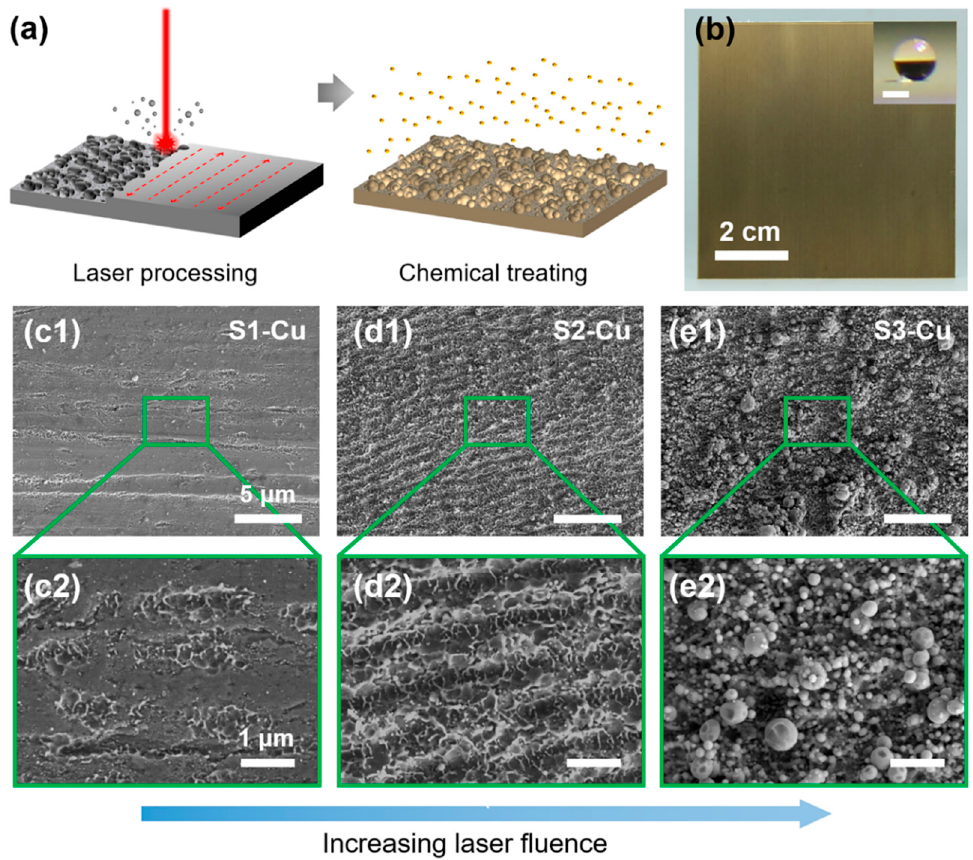
Figure 1. Preparation of condensate self-removing surfaces. ( a ) Schematic showing the fabrication process of the samples via ultrafast laser scanning. ( b ) Digital photographs of the resulting superhydrophobic surface (75 × 75 mm 2 ); scale bar in the inset is 1, in which ( c – e ) SEM images of the representative copper-zinc alloy (Cu) surface types with distinct surface morphologies for ( c1 , c2 ) S1-Cu, ( d1 , d2 ) S2-Cu, and ( e1 , e2 ) S3-Cu.